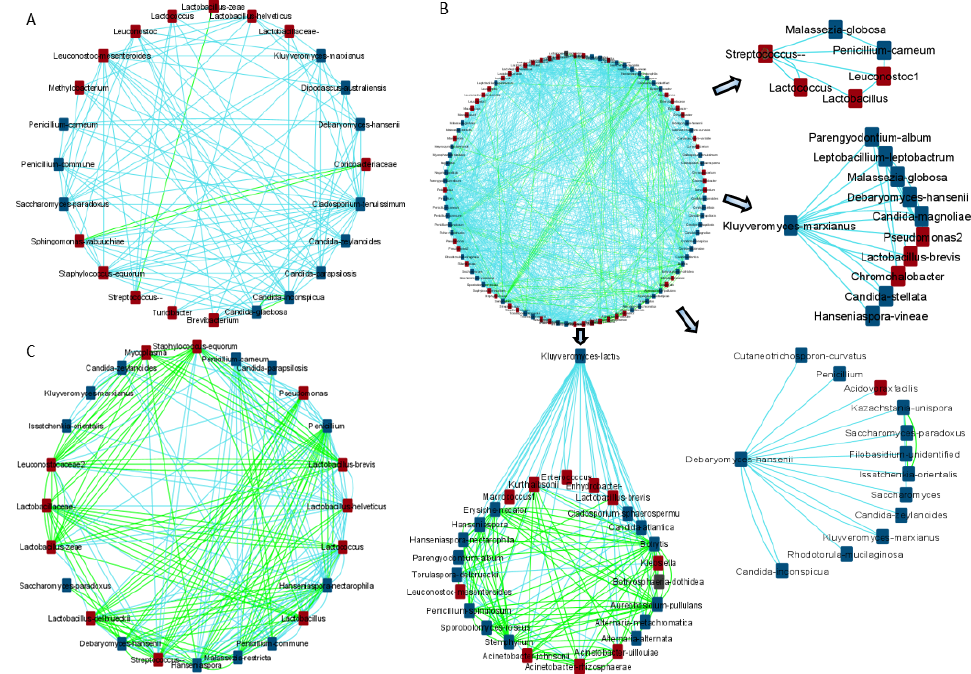
Figure 8. The correlation pattern of microbial communities in: ( A ) Irish cheeses; ( B ) Greek cheeses; ( C ) Cypriot cheeses. Green and light-blue edges represent positive or negative correlations between two nodes, based on Spearman’s rank correlation, the Pearson correlation, and the Bray Curtis and Kullback–Leibler dissimilarity matrices. Red and blue squares represent the bacterial and the fungal taxa, respectively.